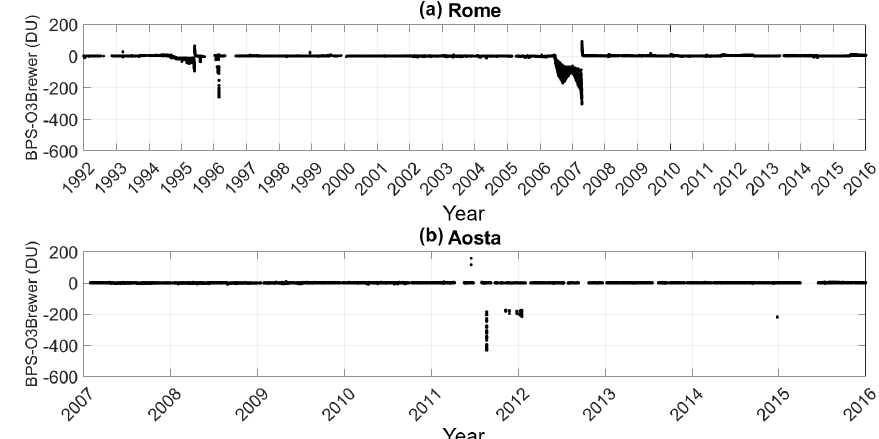
Figure 5. Time plot of the differences between individual BPS and O3Brewer ozone values at Rome (a) and at Aosta (b) .